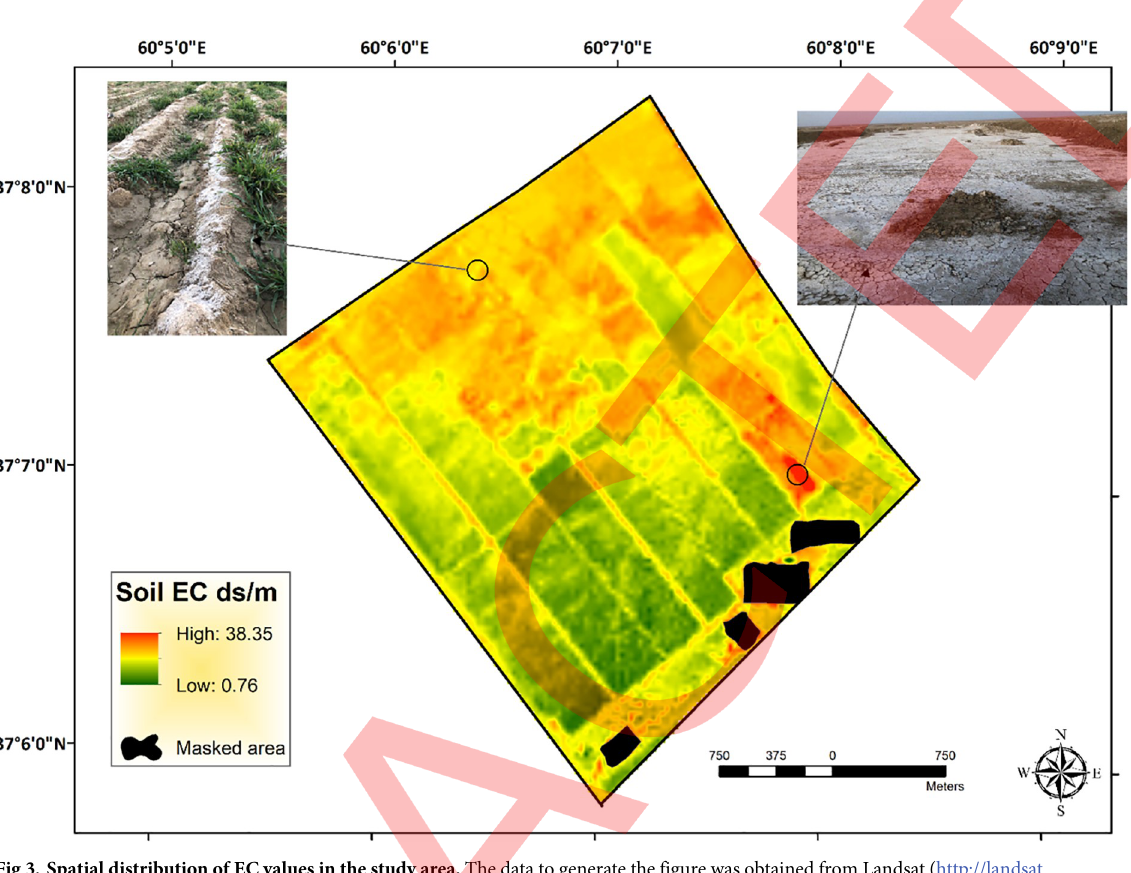
Fig 3. Spatial distribution of EC values in the study area. The data to generate the figure was obtained from Landsat (http://landsat. visibleearth.nasa.gov/).